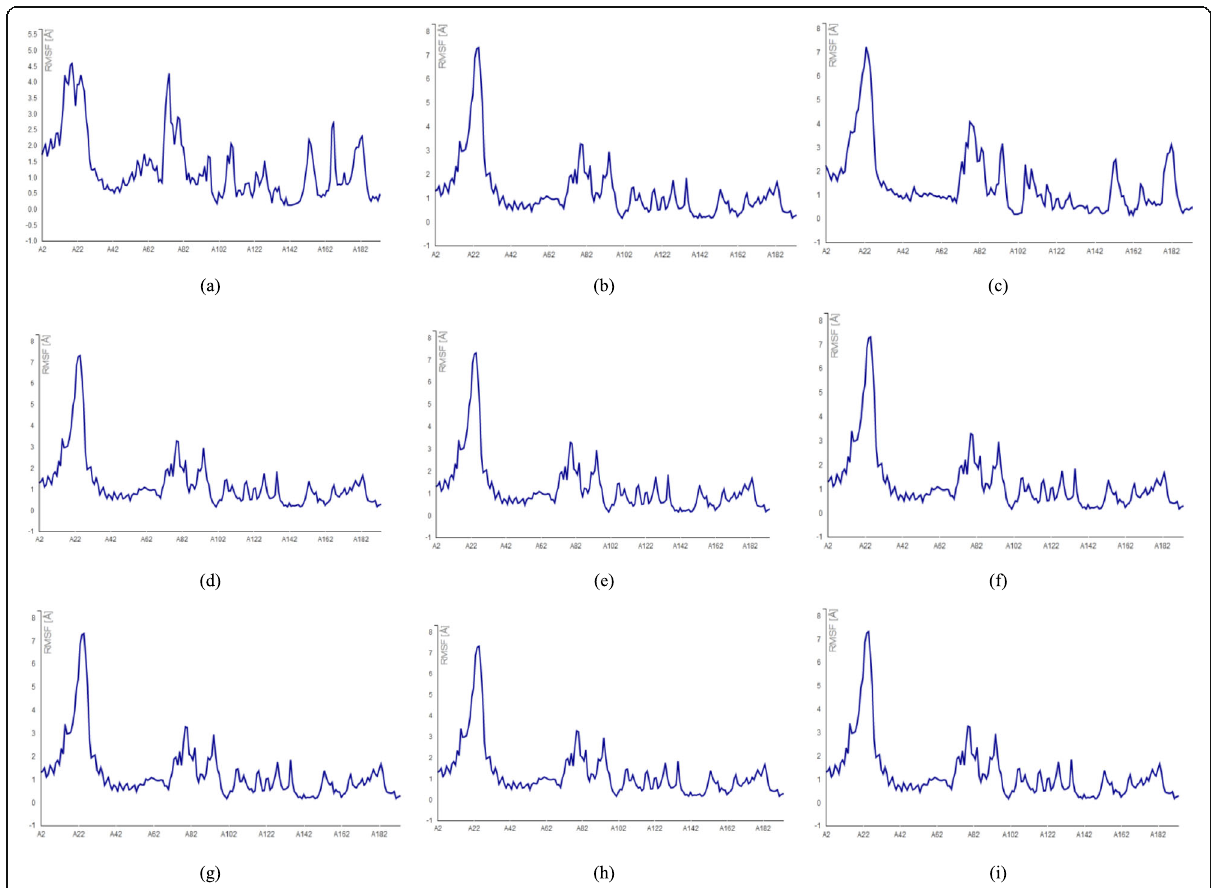
Fig. 12 Molecular dynamics simulation showing the RMSF of a the wild-type TNFL8 and the complexes between TNFL8 and b xylopic acid, c caffeic acid, d chlorogenic acid, e ellagic acid, f apigenin, g rutin, h kaempferol, and i